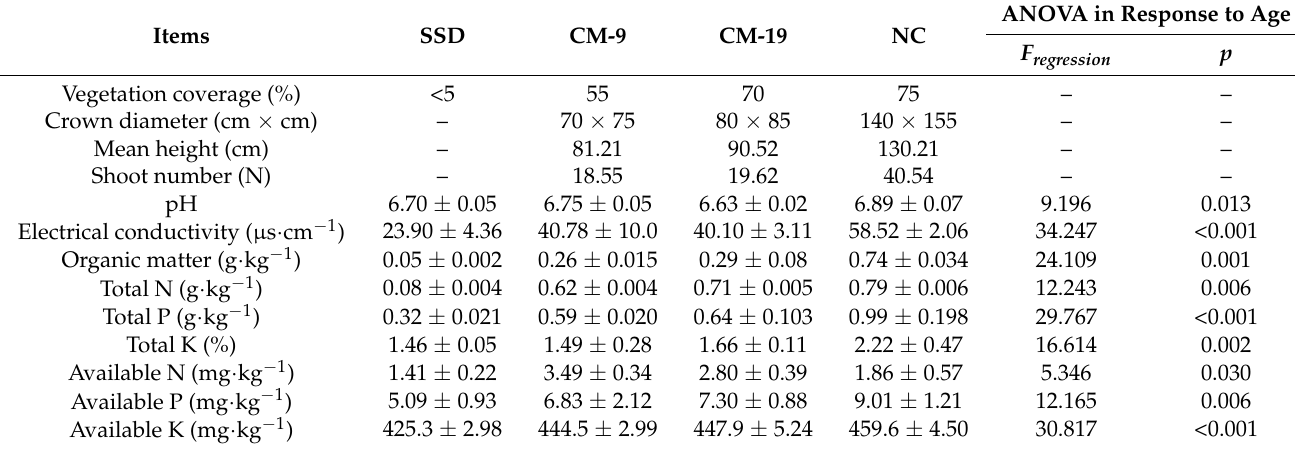
Table 1. Morphological traits, soil pH, electrical conductivity (EC), and nutrients of C. microphylla sand-fixation